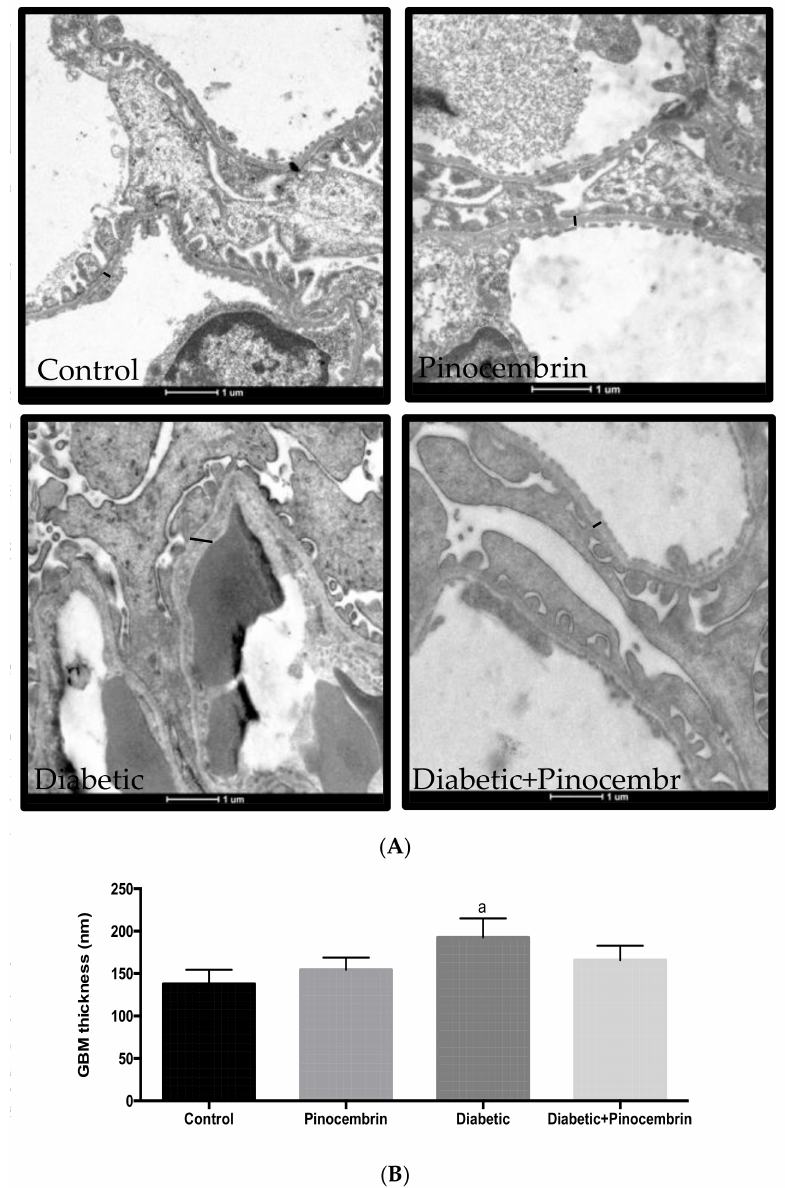
Figure 6. Representative photomicrographs of glomerulus ultrastructure in the preventive scheme. ( A ) Representative images of electron microscopy of preventive model, where measurements of GBM are expressed in nm. Scale bar = 1 µ m; ( B ) Means ± SEM. a p < 0.01 vs. Control, n =